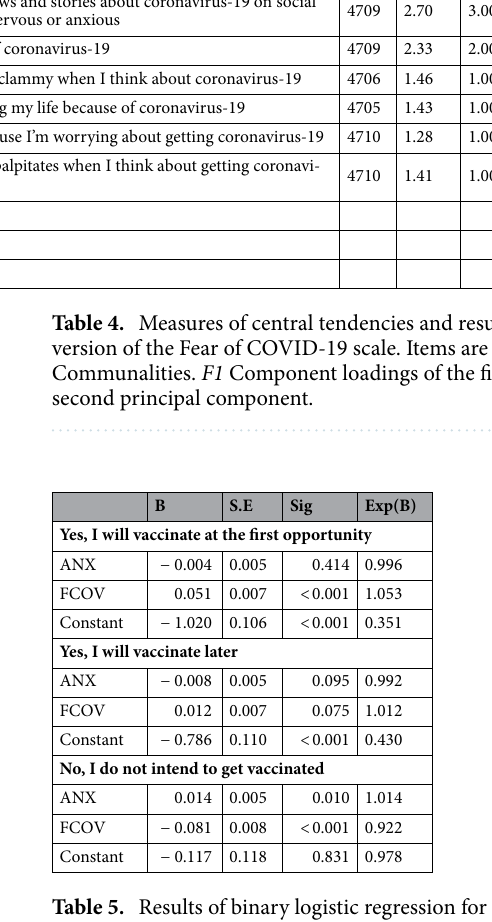
Table 5. Results of binary logistic regression for the whole sample of tertiary students (N = 5779). ANX sums of GAD-7 scale, FCOV sums of FCV-19S scale, B (Beta) coefficient for the constant. S. E. standard error, Sig. significance, Exp(B) the odds